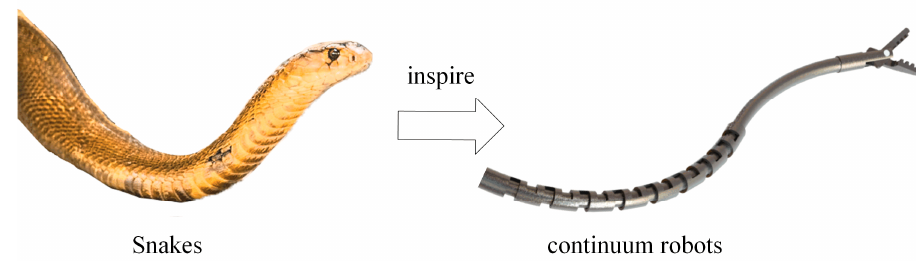
Figure 1. Bio-inspired continuum